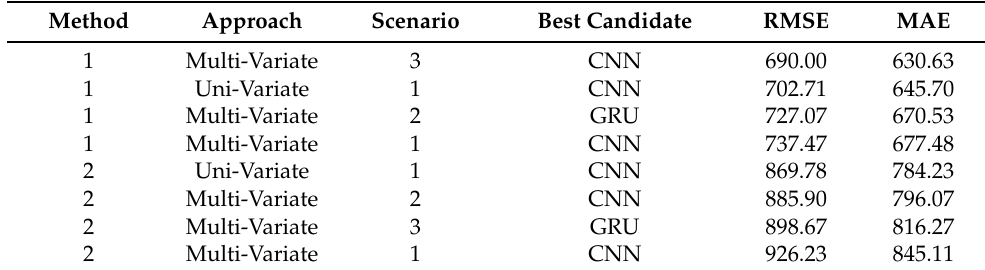
Table 10. Ordered list of best candidate models.